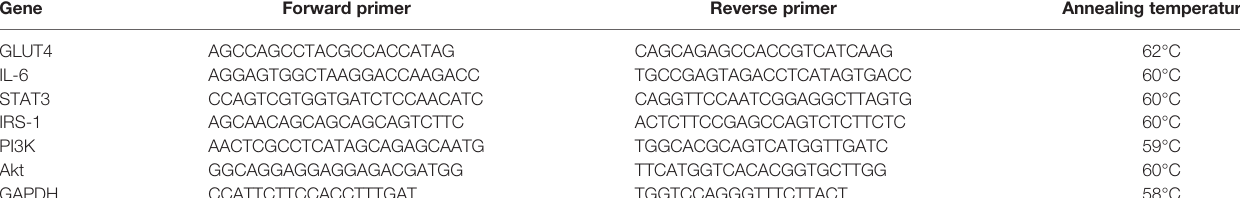
TABLE 1 | Sequence of oligonucleotides used for